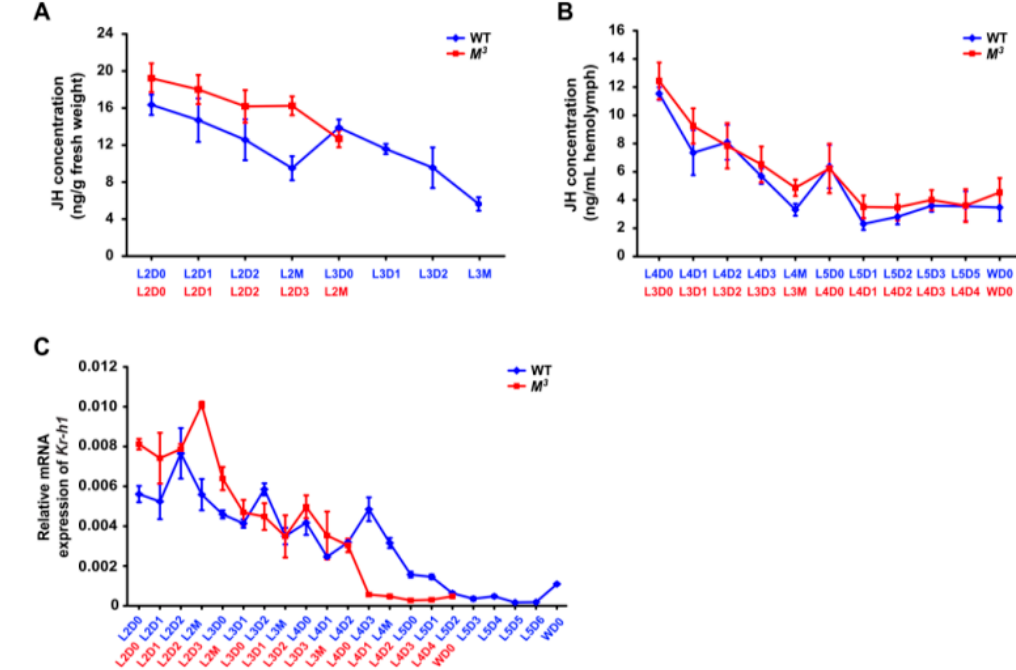
Figure 2. JH concentration and developmental expression of the Kr-h1 gene in the M 3 and WT larvae. ( A ) JH concentration in the whole bodies of the M 3 and WT larvae during early instars. GC-MS analysis indicated that the JH titer in the whole body of the M 3 mutant larvae was higher than that of the WT larvae in the second instar; ( B ) JH concentration in the hemolymph of the M 3 and WT larvae during late instars. GC-MS analysis indicated that the JH titer in the hemolymph of either the M 3 mutant or WT larvae were similarly decreased to low levels at the final instar; ( C ) Kr-h1 expression in the integument of the M 3 and WT larvae. qRT-PCR analysis indicated that the expression level of the JH-responsive gene Kr-h1 was higher in the M 3 larvae than in the WT larvae in the second instar, and Kr-h1 was expressed at very low levels in the final instar of both the M 3 and WT larvae. L, larval instar; L2 to L5 respectively represents the second to the fifth larval instar; D, day; D0, initial day; D1 to D6 respectively represents the first to the sixth day of a larval instar; M, molting; W, wandering. The error bars represent the mean ± S.E. ( n = 3).